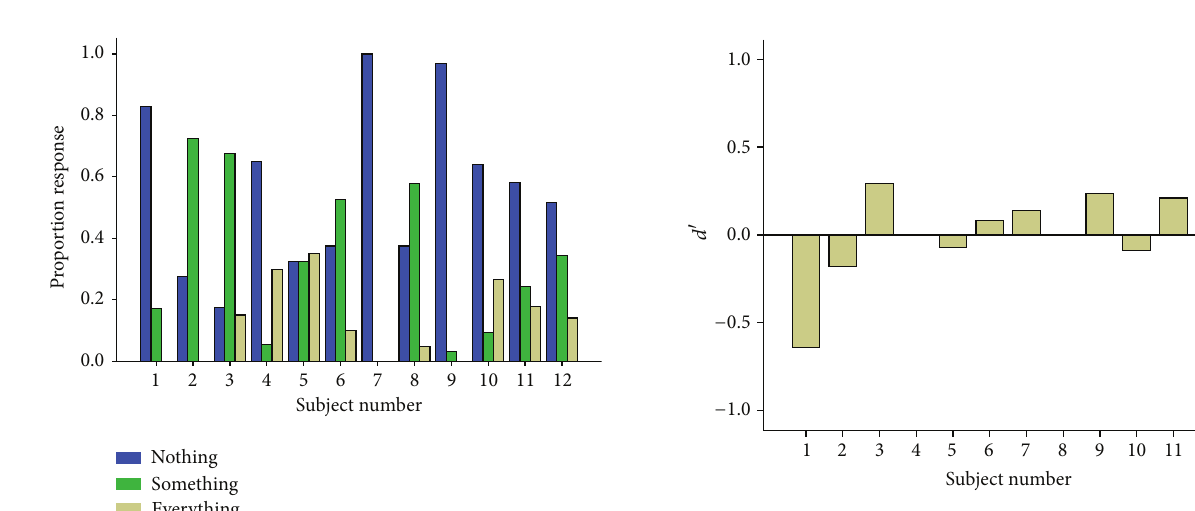
Figure 4: Sensitivity of individual participants in the face detection